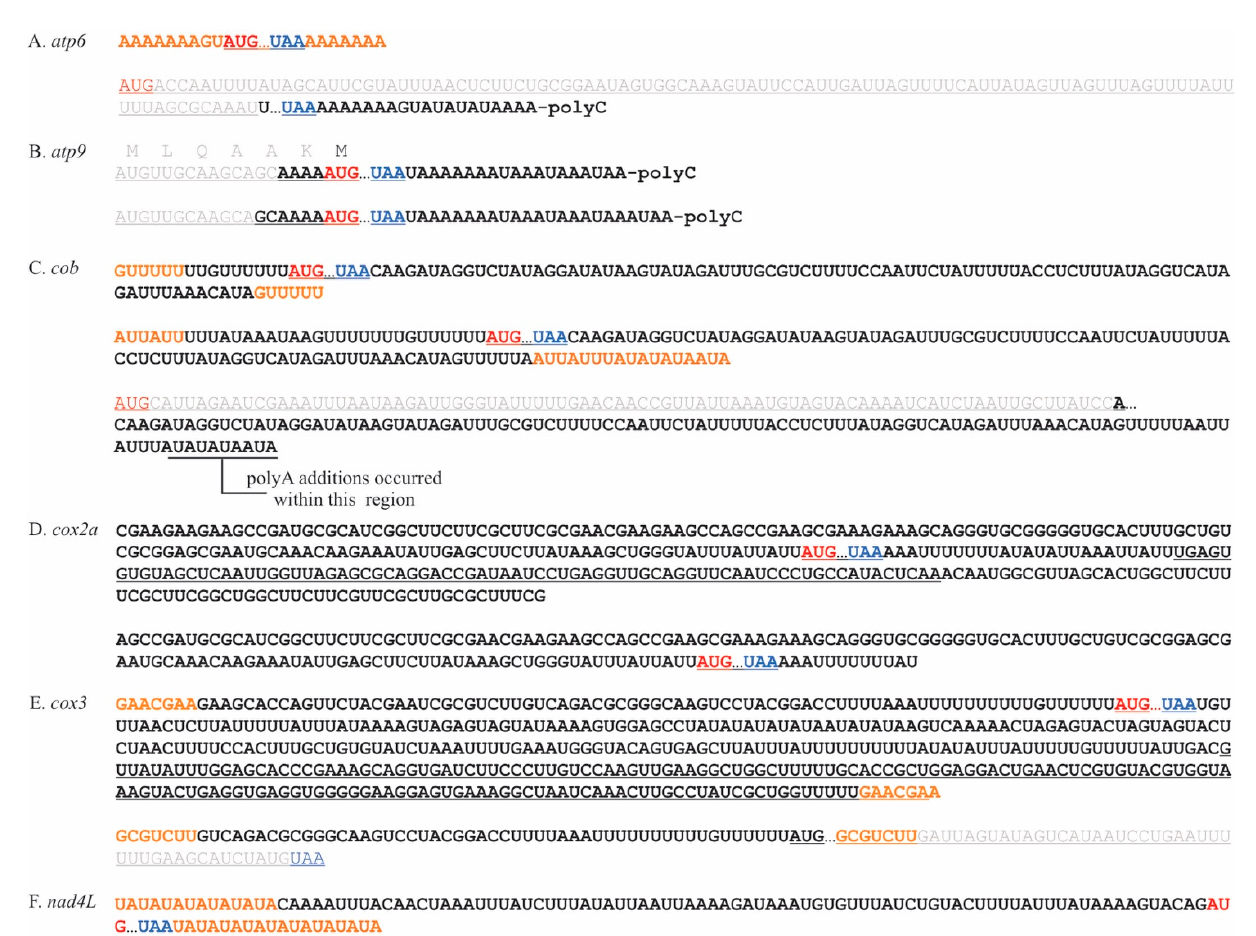
Figure 3. Naturally circularized mRNAs found in P. duplex mitochondria. Start codons are colored red, stop codons blue, repeat sequences orange, and truncated portions of coding regions grey. ( A ). Two circularized mRNAs were detected for the gene atp6 , the upper sequence represents a full-length coding region whose 3 ′ and 5 ′ termini were ligated within templated adenine stretches that flank the coding region. The lower sequence represents a circularized portion of the mRNA. ( B ). Two versions of a circularized atp9 transcript were detected. Both would be full length considering a start codon downstream of the previously predicted one (grey) would be the actual start codon. ( C ). Two full-length circularized versions of the cob transcript were detected (upper two sequences). The ligation termini coincided with two different repeat sequences (orange). A third circularized transcript with a truncated coding region was also detected for cob . ( D ). Two circularized full-length coding regions were detected for cox2a . ( E ). Two circularized cox3 transcripts were detected, both ligations having occurred at repeat sequences. One carried a full-length coding region (upper) the other truncated (lower). ( F ). Two full-length circularized versions of the nad4L transcript were detected where ligation occurred at AU-rich repeat sequences. ( G ). One circularized nad5 transcript was detected with the ligation occurring within AU-rich repeat sequences.